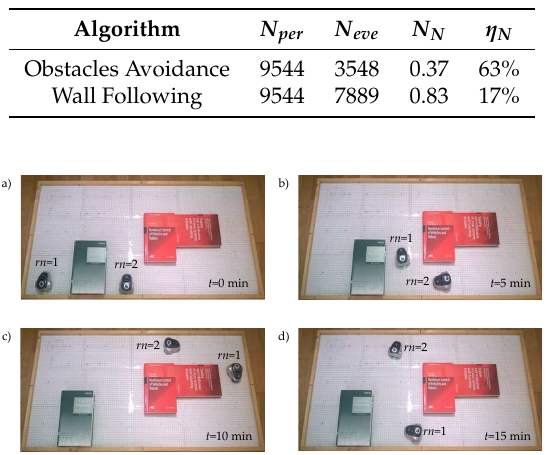
Table 3. Algorithm activity by architecture, number of samples, number of events, ratio of events and event efficiency.